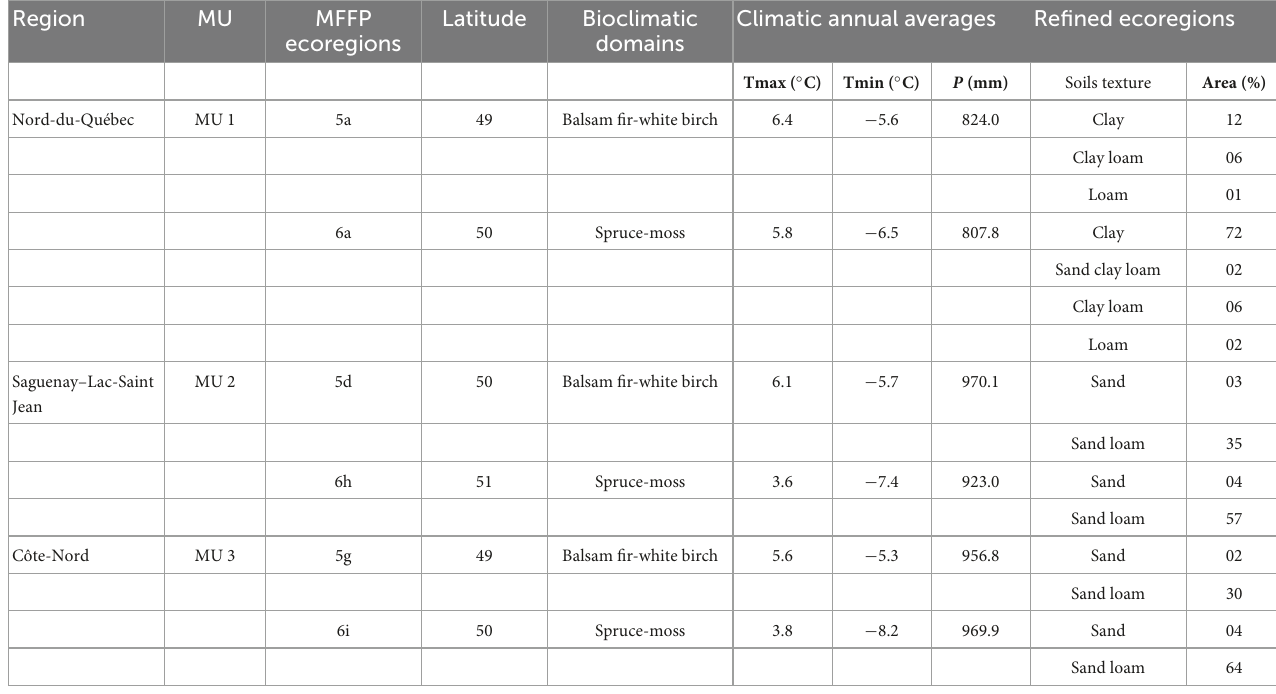
TABLE 2 The characteristics of used ecoregions during the simulations.